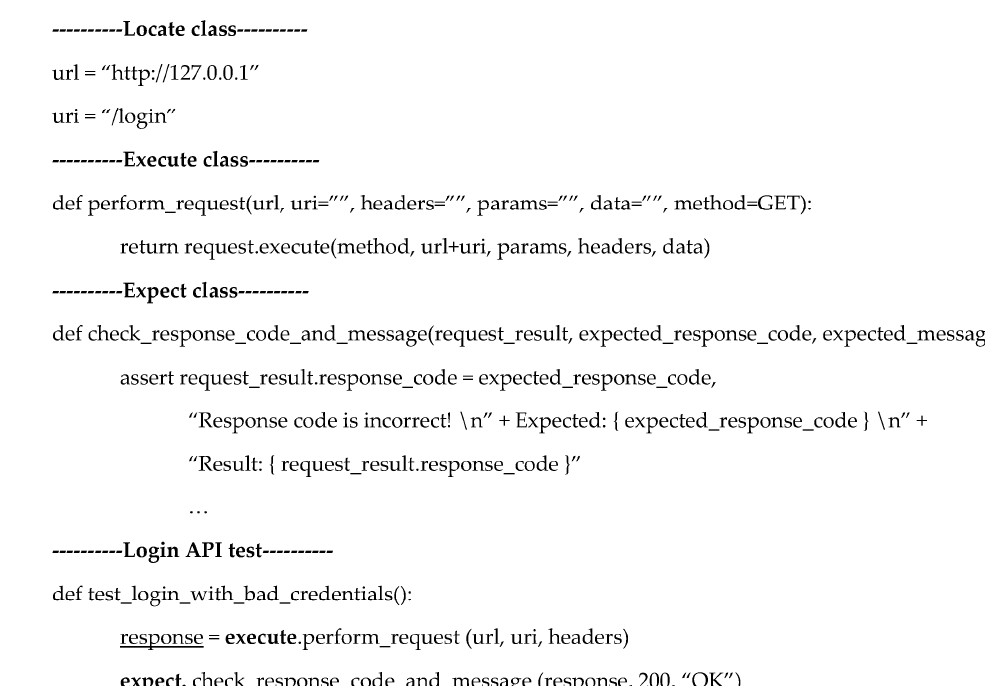
Figure 14. API test example for login with bad credentials test.